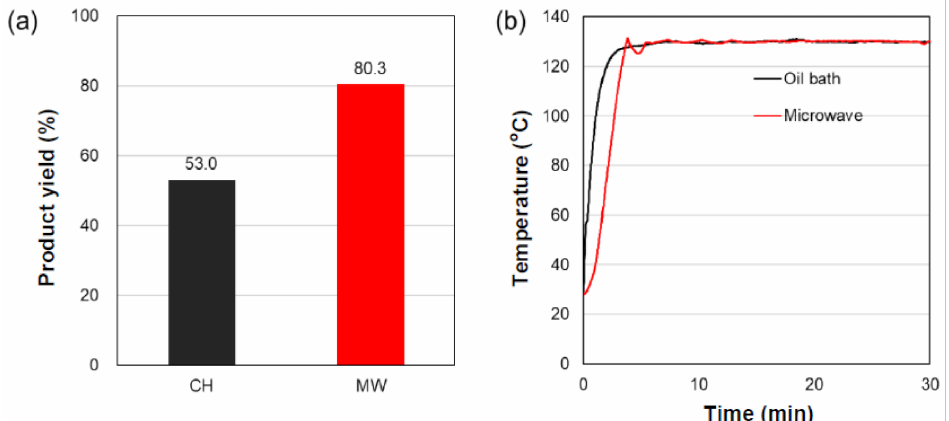
Figure 1. ( a ) Product yields and ( b ) internal temperature profiles in the synthesis of the heptyl butanoate ester catalyzed by AC-SO 3 H particulates under oil-bath heating (CH) and microwave heating (MW)—first experimental run (moisture content determined in pre-distilled butanoic acid batch: